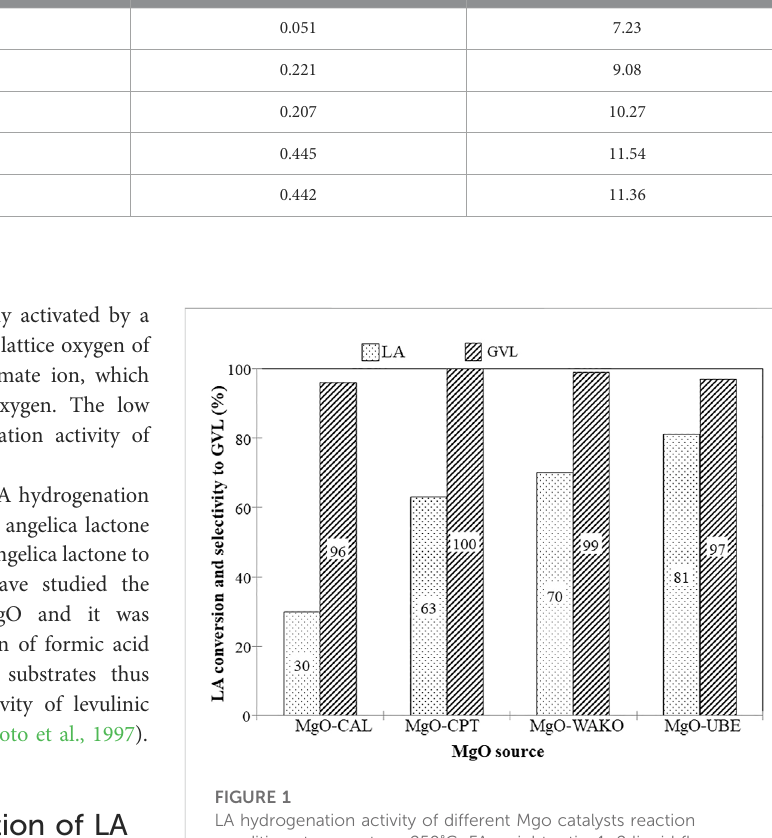
TABLE 2 Physicochemical properties of magnesium oxides. MgO source